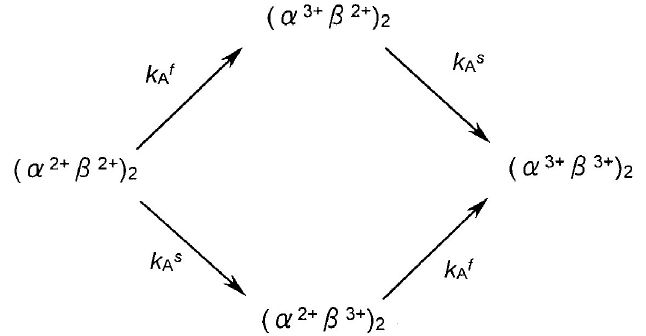
autoxidation. ( a ) Isoelectric-focusing 2